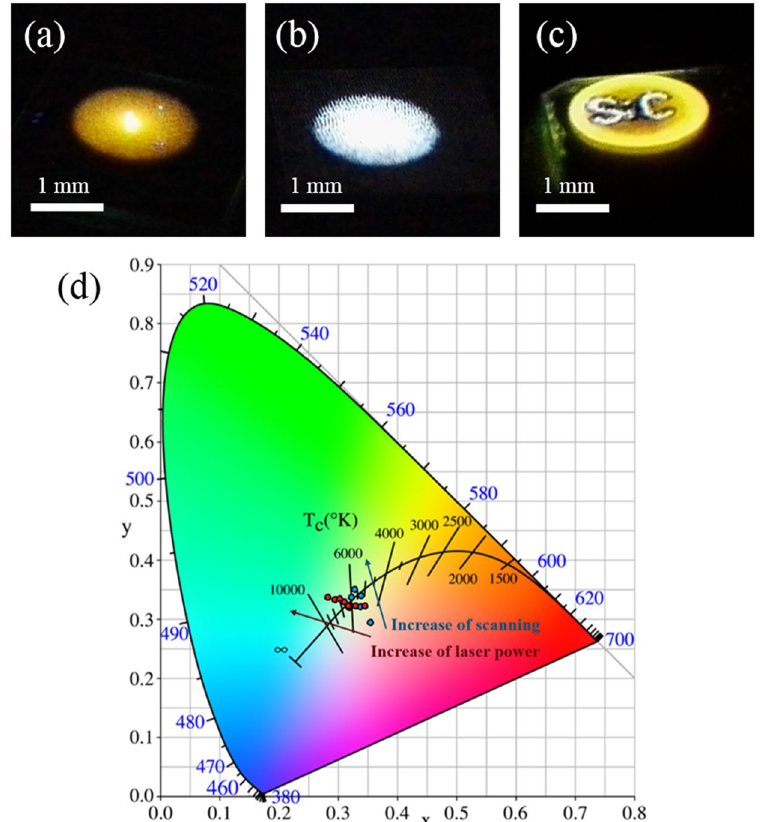
Figure 2. Photographs of the light emission of a ( a ) pristine 6H-SiC surface, ( b ) laser-irradiated 6H-SiC surface (white-PL sample), and ( c ) laser-patterned “SiC” on a 6H-SiC surface following excitation by a 325-nm He–Cd laser. ( d ) The 1931 CIE chromaticity diagram of samples fabricated with different parameters. The red dots from right to left represent the emission of the samples using increasing laser power and the blue dots represent the emission of samples scanned by different scanning